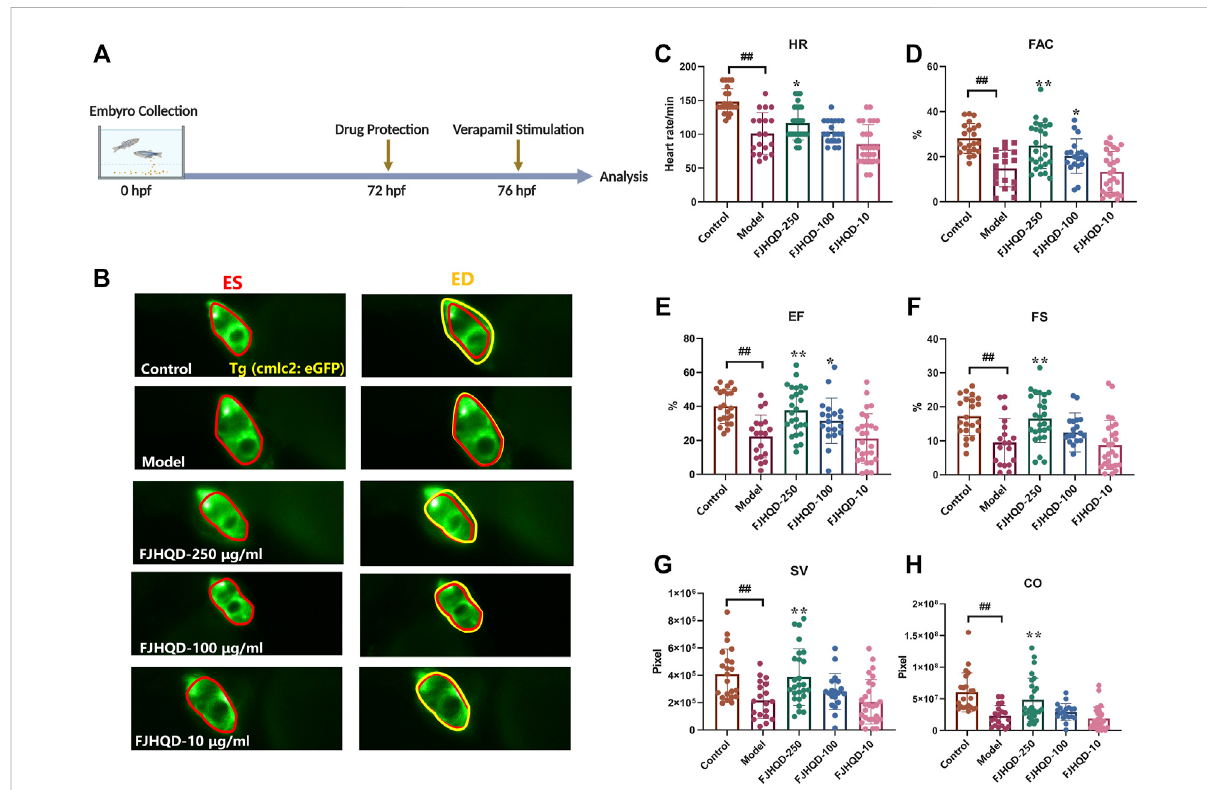
FIGURE 2 FJHQD alleviates cardiac function in verapamil-induced heart failure model (A) Experimental scheme for heart failure model in zebra fi sh. (B) Representative images ofvehicle-treated and verapamil-treated zebra fi sh heart. The heart of ES wasshown inred line, theheart ofED was shown in yellow line (C – H) Quanti fi cation of cardiac function in Tg(cmlc2: eGFP) zebra fi sh larvae treated with FJHQD. n ≥ 19. # p < 0.05 vs . Control, ## p < 0.01 vs . Control, * p < 0.05 vs . Model, ** p < 0.01 vs .